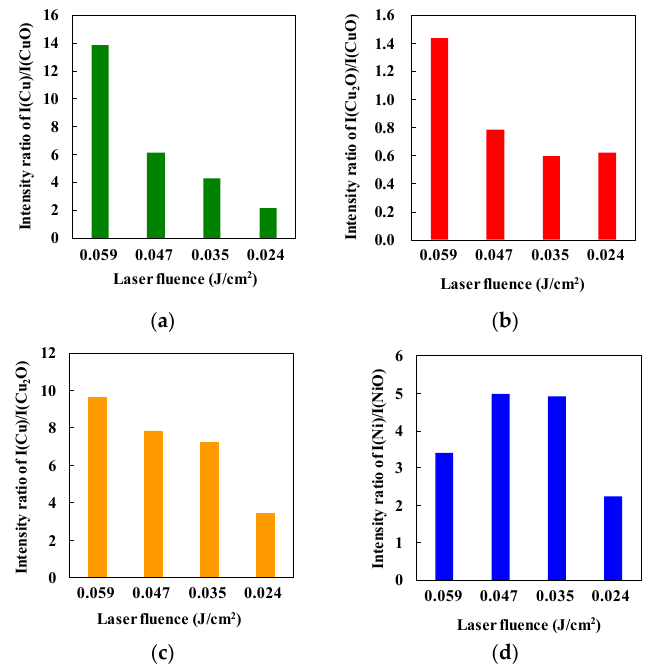
Figure 5. Intensity ratios of ( a ) I(Cu)/I(CuO), ( b ) I(Cu 2 O)/I(CuO), ( c ) I(Cu)/I(Cu 2 O), and ( d ) I(Ni)/I(NiO). Table 3. Seebeck coefficients of the micropatterns at constant total irradiation energy and various writing speeds.